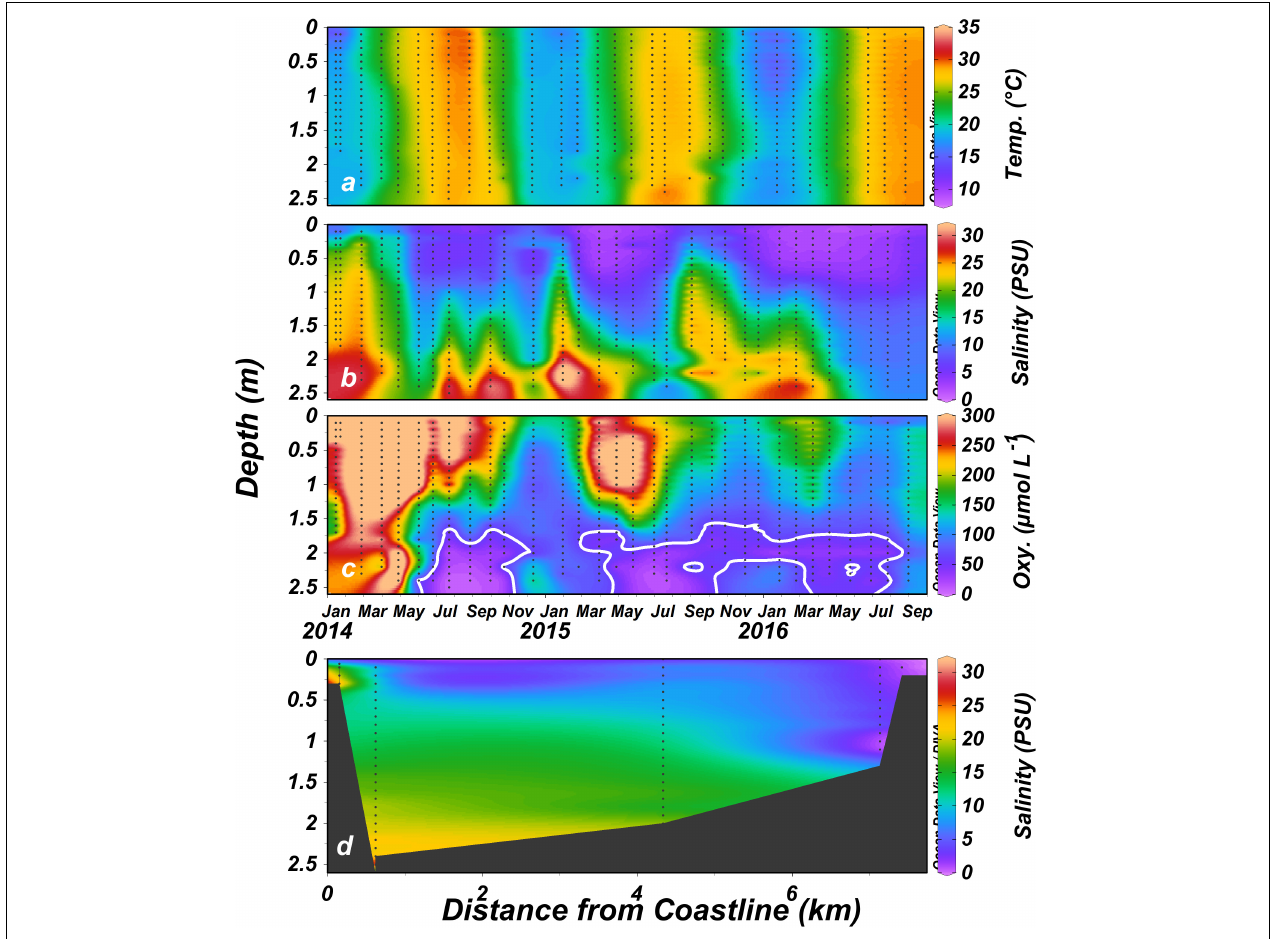
FIGURE 3 | Temperature (a) , salinity (PSU) (b,d) , and dissolved oxygen ( µ mol L − 1 ) (c) ∼ 350 m upstream from the Alexander estuary mouth (January 2014 to August 2016). The white contour lines in (c) represent hypoxic conditions. Black dots represent sampling locations. The average salinity distribution throughout the research period is presented in (d)